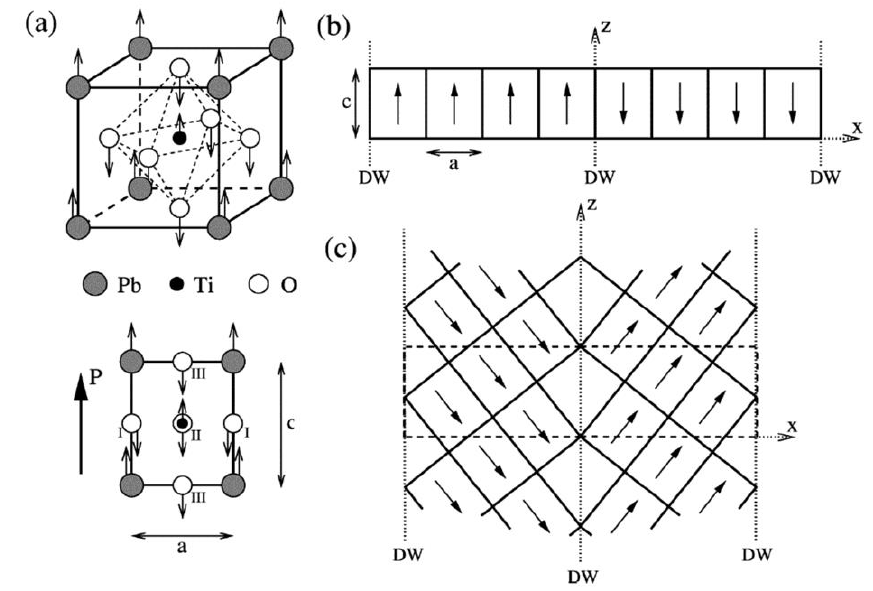
Figure 4. ( a ) Unit cell of the cubic perovskite structure and its projection along the [010] direction; arrows indicate atomic displacements in the ferroelectric tetragonal phase; ( b , c ) Supercell geometries containing eight perovskite primitive cells for ( b ) 180° and ( c ) 90° domain walls; atoms are omitted and only solid lines connecting the Pb atoms are drawn. Supercell boundaries are indicated by dashed lines. (Reproduced with permission from